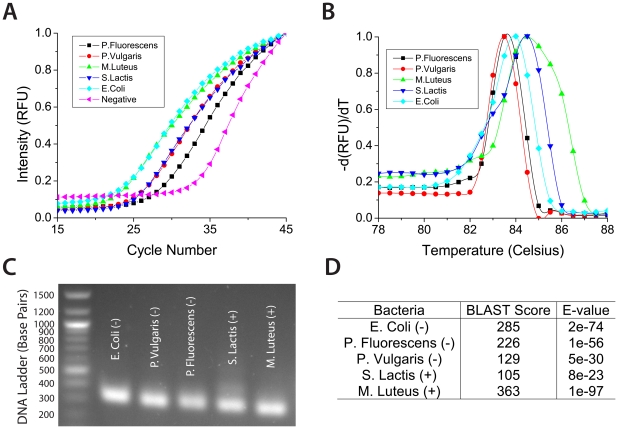
The real-time PCR antibiogram for pan-bacterial detection and identification.a) Pan-bacterial amplification illustrates universal binding of the primers and b) melt curve analysis provides evidence that consistent, species-specific amplicons were generated. c) Amplicons run on gel electrophoresis exhibit similar lengths of 200-300 base pairs and d) sequences submitted to the BLAST are readily identifiable.